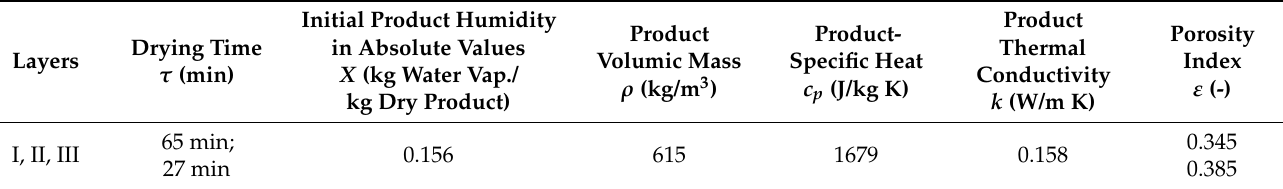
Table 1. Initial conditions imposed for corn seed